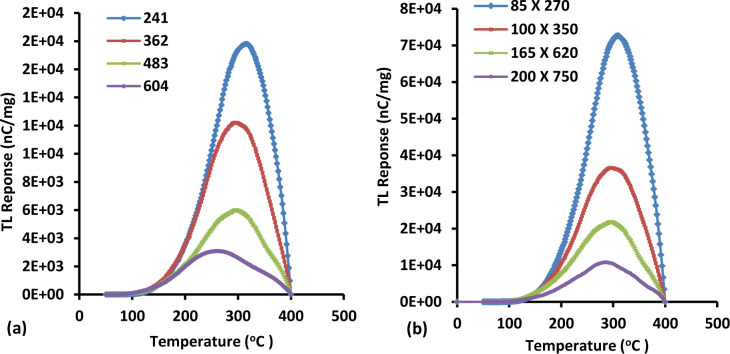
Typical Ge-doped (a) cylindrical and (b) flat fibre TL glow curves, all for a dose of 2 Gy at 6 MeV and 400 MU/min for energy and dose rate respectively, encompassed between temperatures of ~ 50 ºC and 400 ºC in order to determine the effect of different diameters of fibre on the TL glow curve.